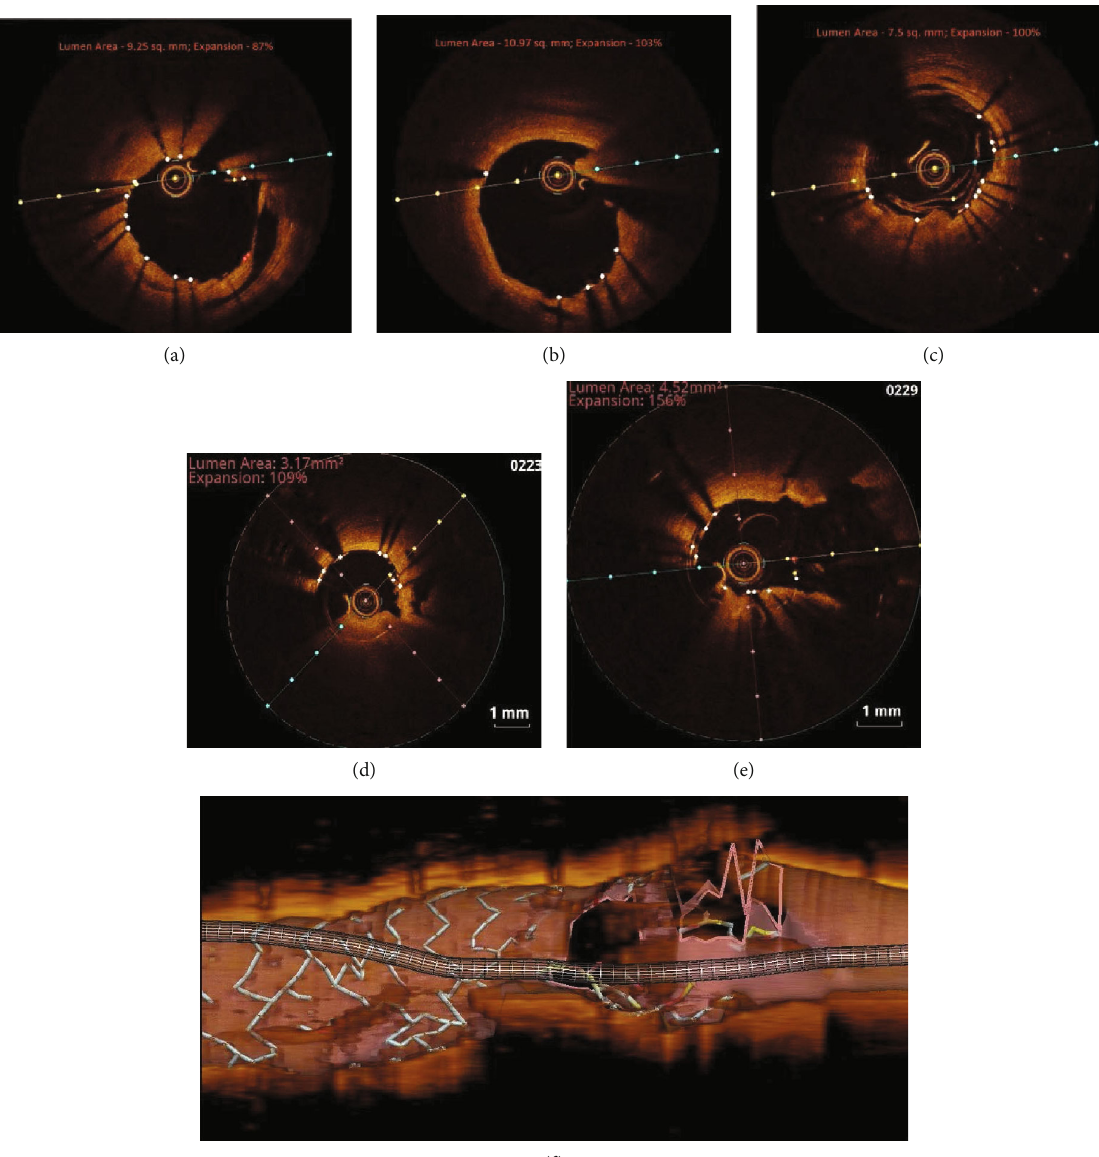
Figure 3: (a) RCA showing intimal tear within stented segment. (b) Proximal edge with no edge dissection. (c) RCA — distal edge. (d) CX — tissue prolapse. (e) CX bifurcation view — no pinching. (f). CX bifurcation view —